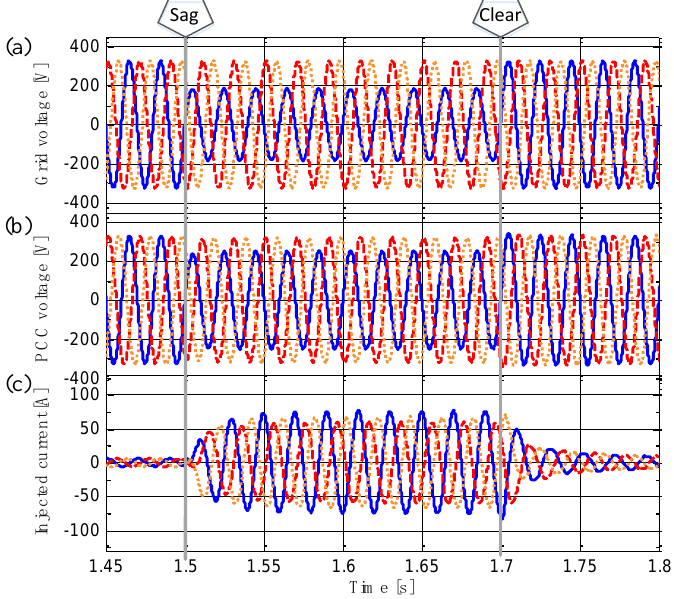
Figure 7. Response of the SPC-based power converter under an asymmetrical grid fault when A pos = 1, A neg = 0.1 A pos : ( a ) grid voltage; ( b ) PCC voltage; and ( c ) current injected by the converter. The rms value for the positive- and negative-sequence components of the voltage at the PCC and the injected current, calculated by V + in Figure